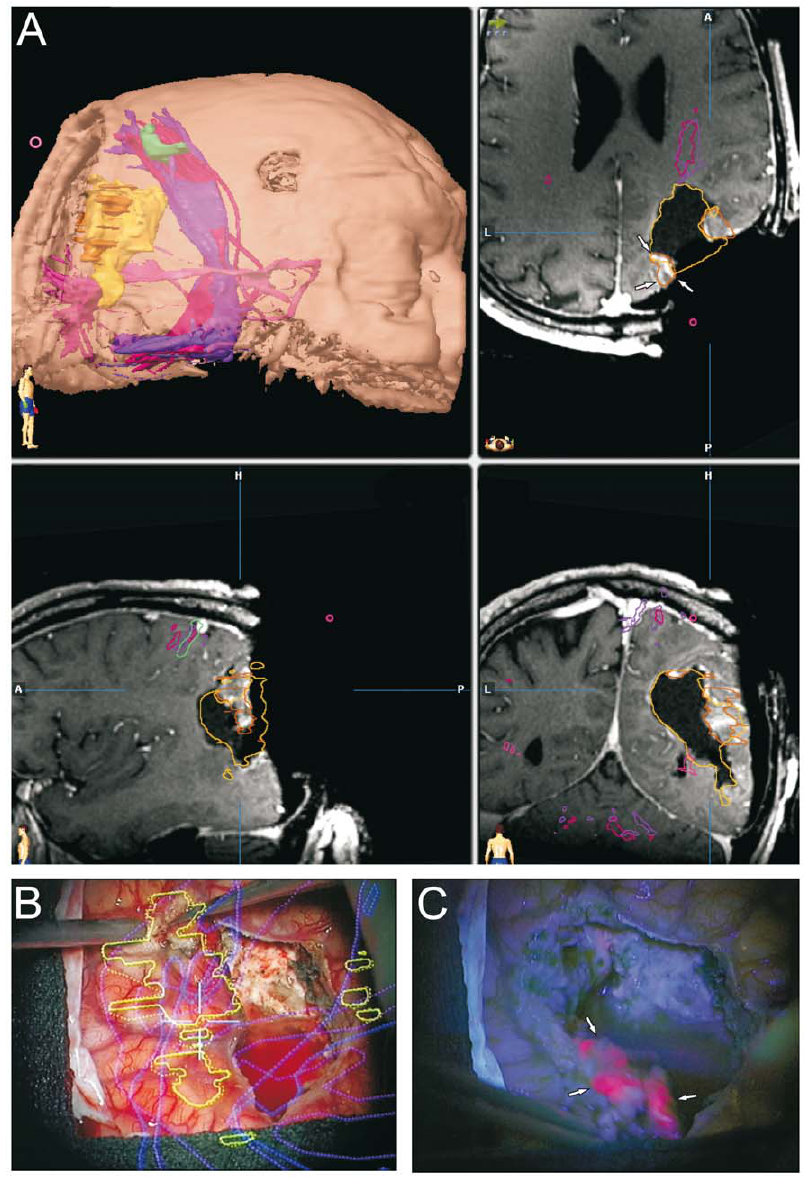
Figure 3. Dual intraoperative visualization approach and anatomical view. On the basis of a typical case of a tumor in the vicinity of an eloquent area, we demonstrate that the risk of missing tumor remnants covered by non-pathological tissue is eliminated through an iMRI control. A, The first iMRI scan carried out following the disappearance of the 5-ALA signal depicted a residual contrast enhancing area (marked by arrows). B, Tumor resection was resumed following re-segmentation and update of the neuronavigation. C, During resection of the intervening layer of non- pathological tissue, the 5-ALA signal reappeared (marked by arrows) and corresponded to the re-segmented contrast enhancing area.